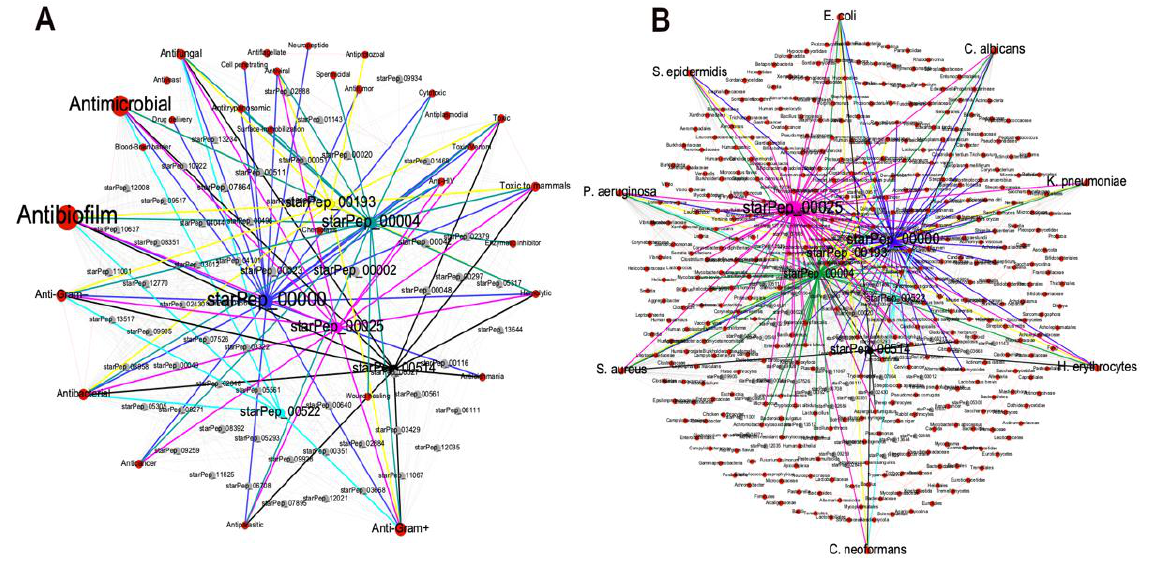
Figure 8. METNs visualization of the representative subset integrated by 66 ABFPs from the HC ∪ HB of the subset 7 (cutoff 0.40) using the Fruchterman–Reingold layout. ( A ) Red nodes represent the bioactivities, while the ABFPs under study, starPep_00000, starPep_00193, starPep_00004, starPep_00025, starPep_00514, and starPep_00522, are in blue, yellow, green, pink black and cyan colors, respectively. ( B ) Red nodes represent the targets on which the ABFPs have been evaluated. The ABFPs under study are highlighted with the color scheme used in A.